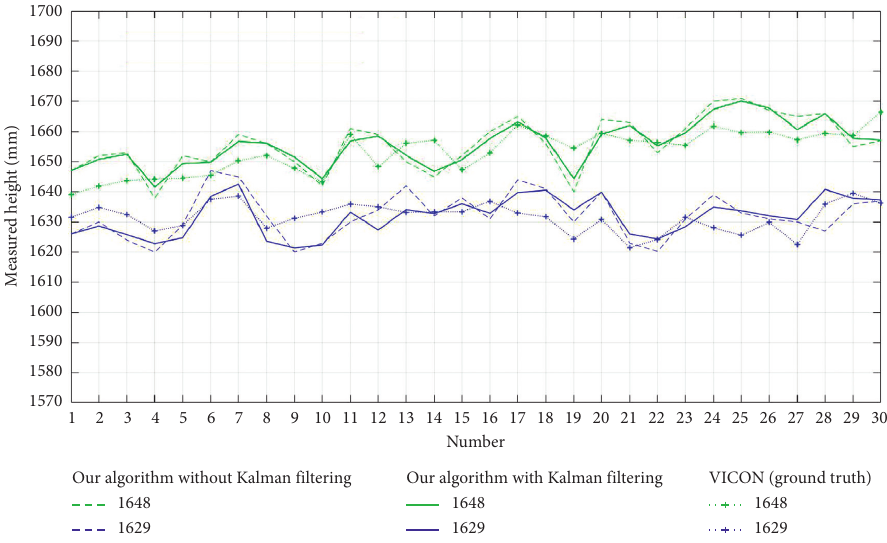
Figure 10: Experimental results of women with different heights in the six consecutive seconds.